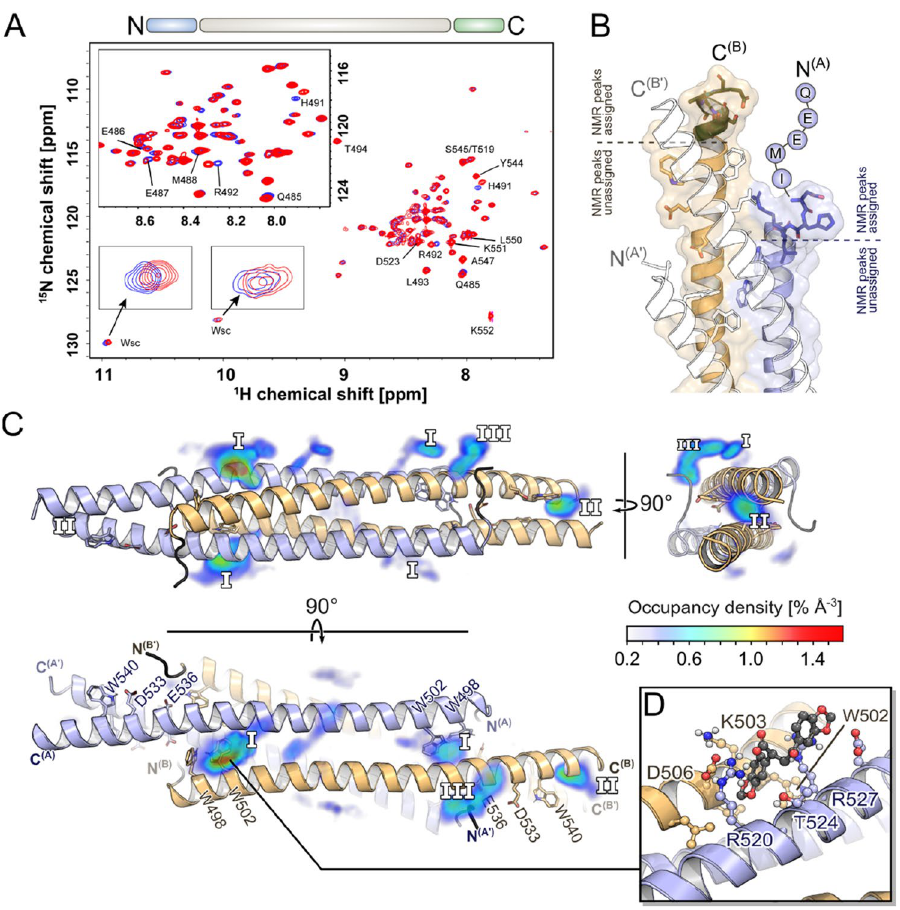
Figure 5. TROSY-HSQC NMR experiments of 2 H, 15 N, 13 C-labeled NHR2 in the absence and presence of 7.44. (A) 2D 1 H– 15 N TROSY-HSQC spectra of 47 µM of apo NHR2 (blue) and in complex with 2 mM of 7.44